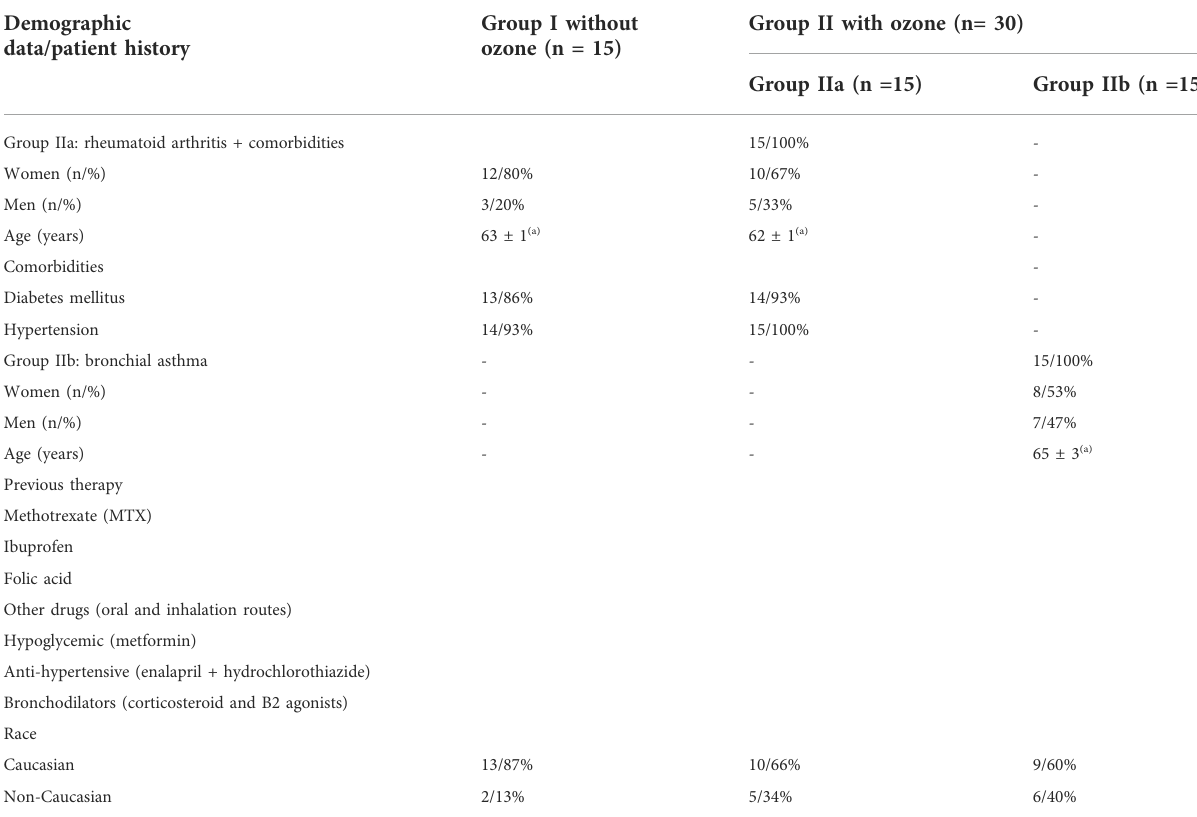
TABLE 1 Clinical images of older patients (60-70 years) with oxidative etiology diseases. Demographic data/patient